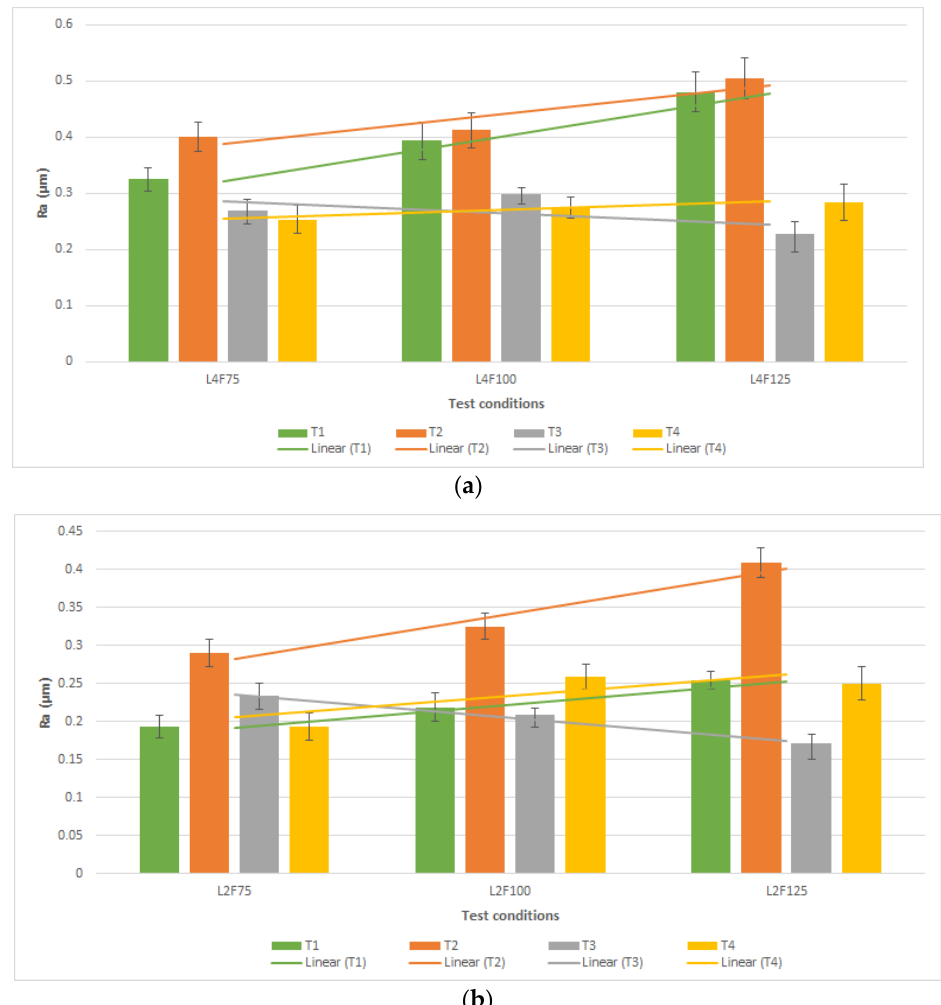
Figure 21. Average values of Ra, measured in the radial direction for T1, T2, T3 and T4 tools, for the test conditions conducted at 2-m cutting length ( a ); and 4-m cutting length ( b ).